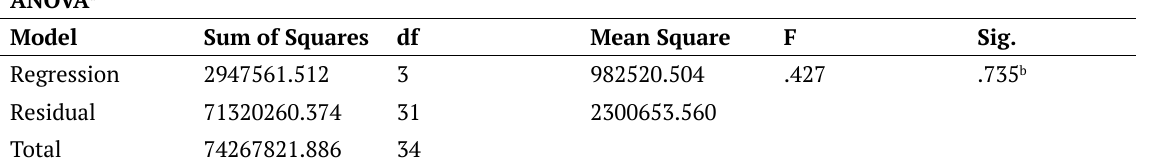
a = Dependent Variable: football skill; b = Predictors: (Constant), aerobic endurance test, agility test, speed